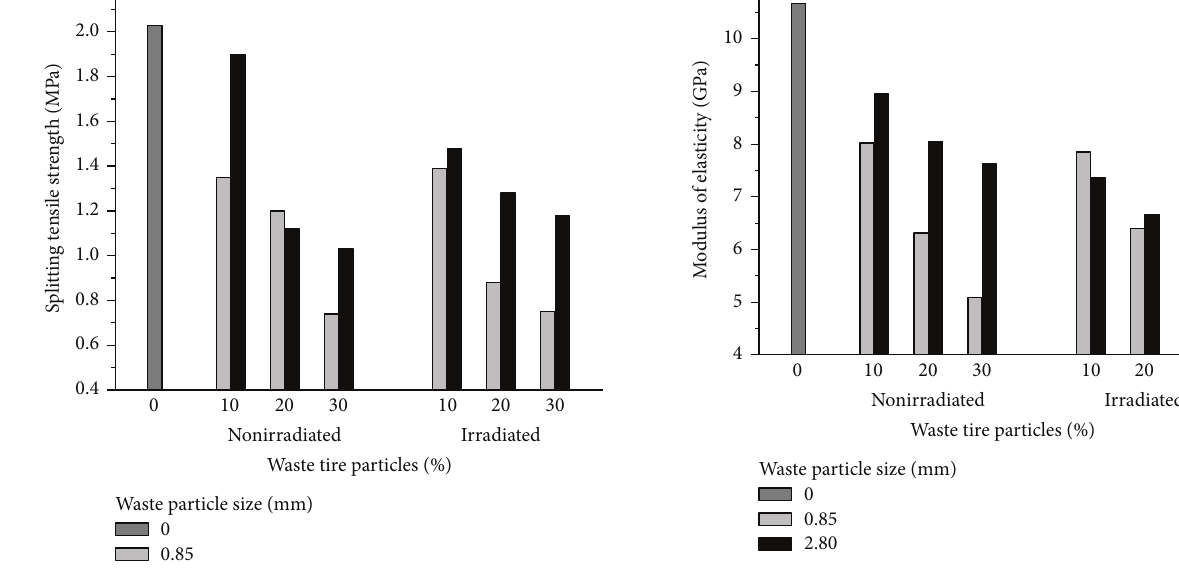
generated in the specimens are of the same nature, they act in the direction of the load application axis.